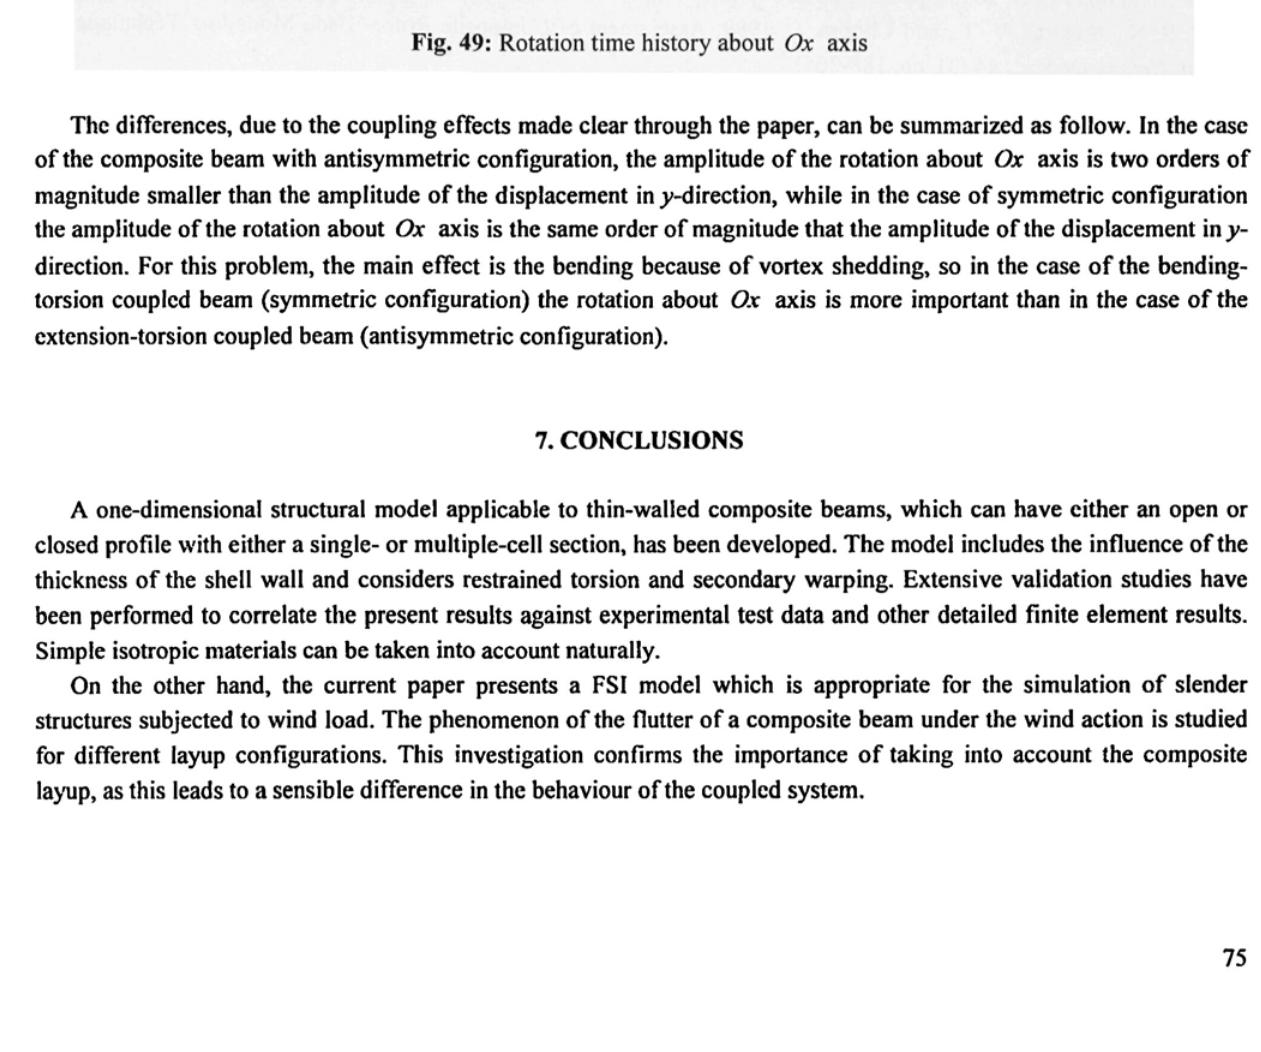
Fig. 48: Displacement time history in y -direction